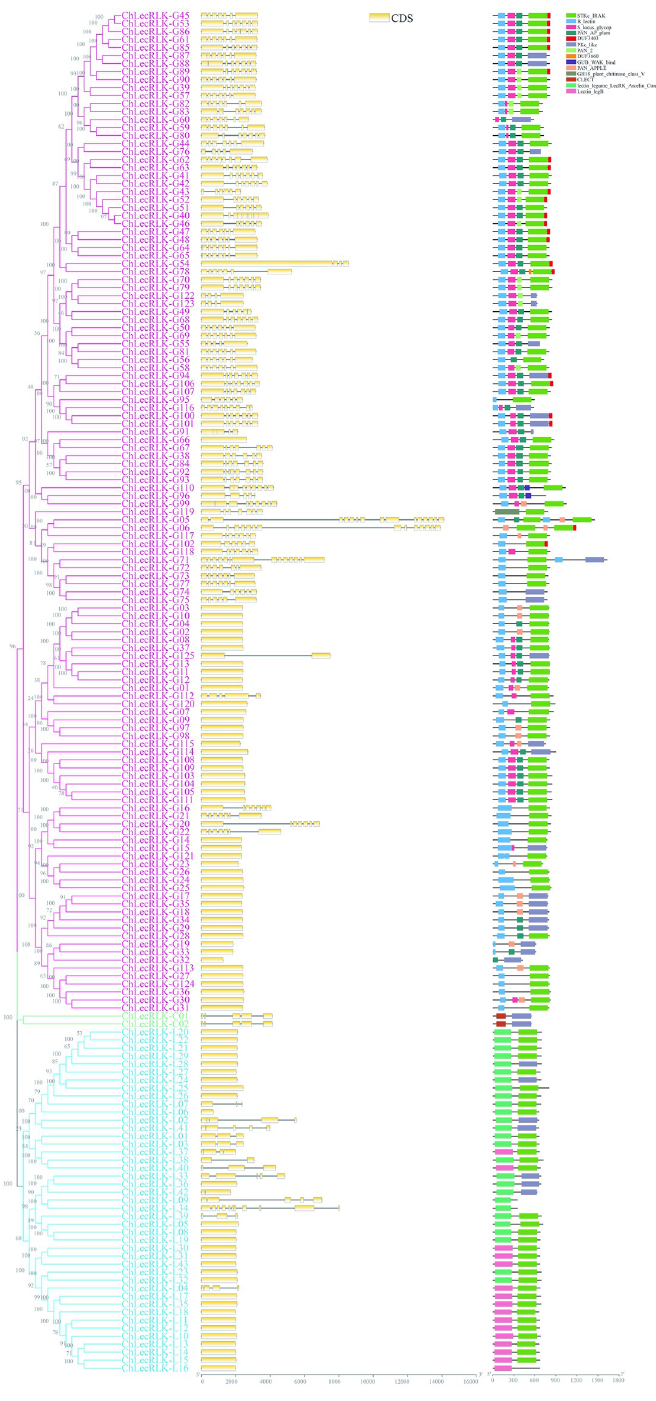
Fig 2. Schematic diagram of the structure of chLecRLK genes (left) and conserved domain of chLecRLK proteins (right).